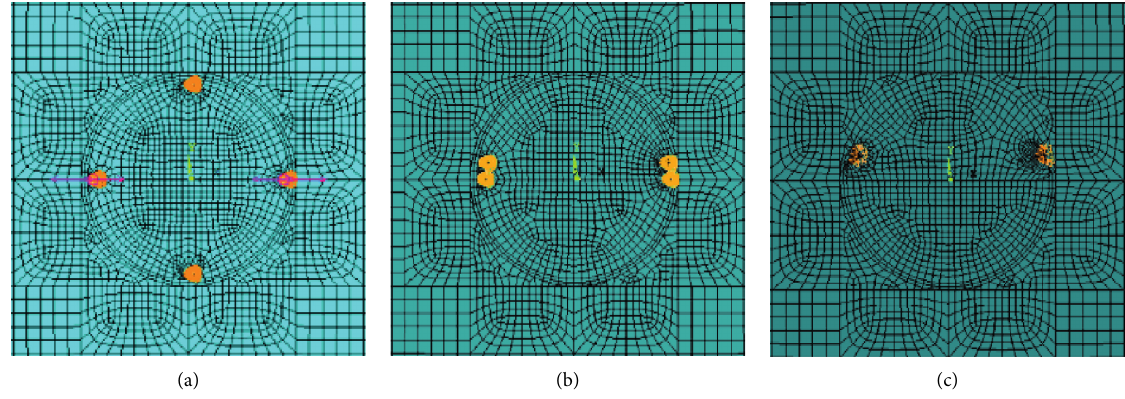
Figure 13: Meshing diagram: (a) SCF; (b) EDCF; (c)